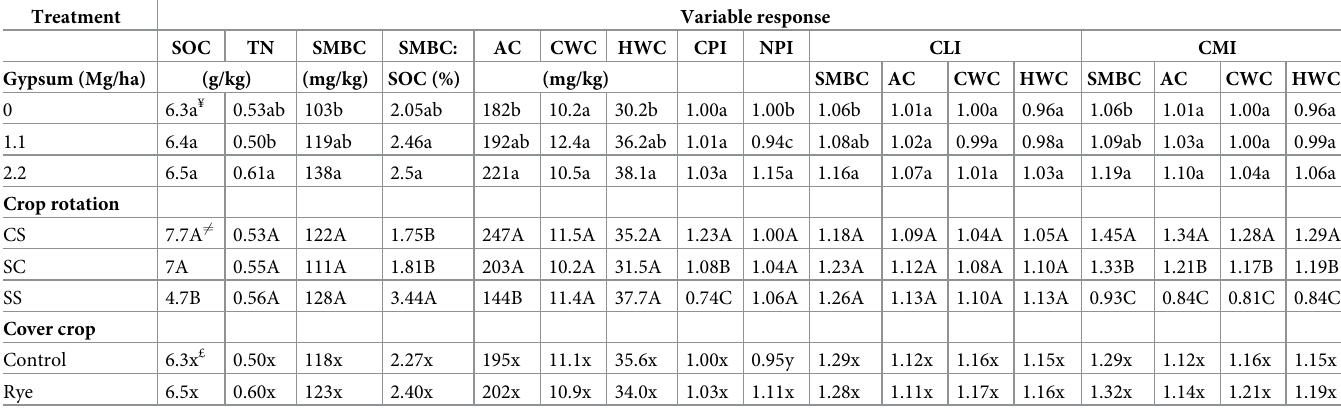
Table 1. Gypsum and cover crop impacts on total soil organic C (SOC), total nitrogen (TN), microbial biomass (SBMC), active carbon (AC), cold (CWC) and hot (HWS) salt water extractable carbon, carbon pool index (CPI), nitrogen pool index (NPI), carbon lability index (CLI), and carbon management index (CMI) under different phases of a rainfed no-till soybean-corn rotation in Alabama (2012 to 2016).